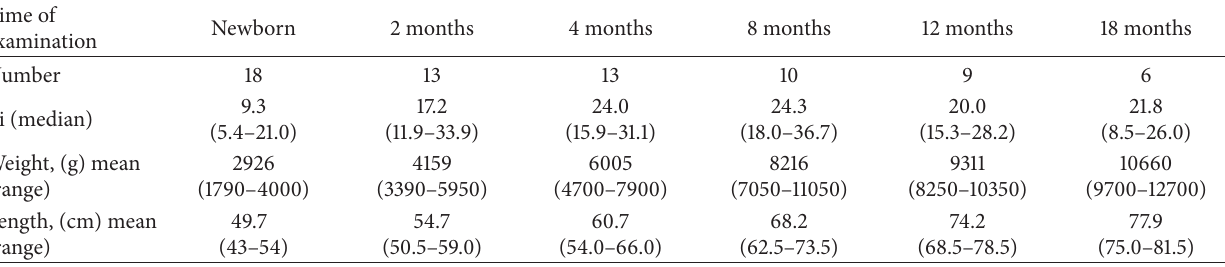
Table 1: HIV-exposed un-infected infants (HIV-EU): the number of infants, the thymic size (thymic index (Ti)), and the weight and length at the times of assessment.